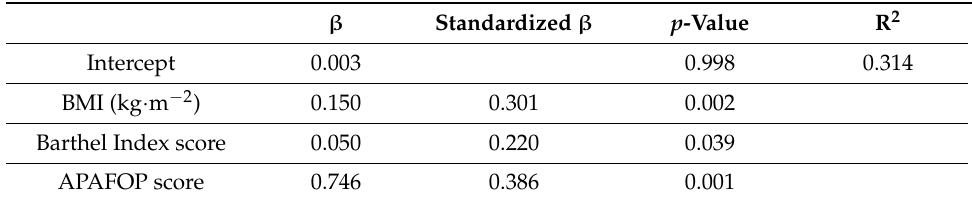
Table 2. Backward stepwise multiple linear regression model predicting the MNA score, controlling for age and sex.